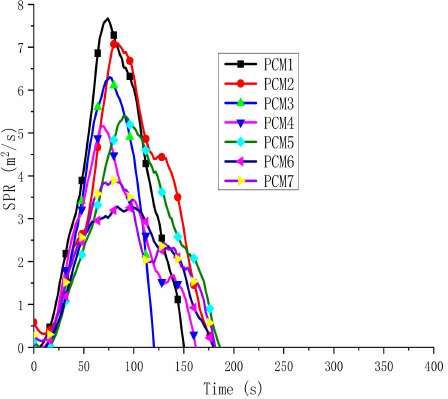
Figure 9. Smoke production rate (SPR) curves of the